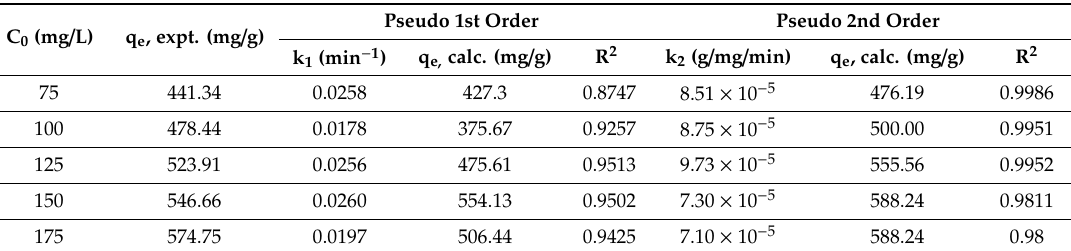
Table 2. Kinetics study of PAN / SL ACNFs at di ff erent initial Pb(II) concentrations. Condition: contact time = 240 min, dosage of adsorbent = 40 mg, pH =